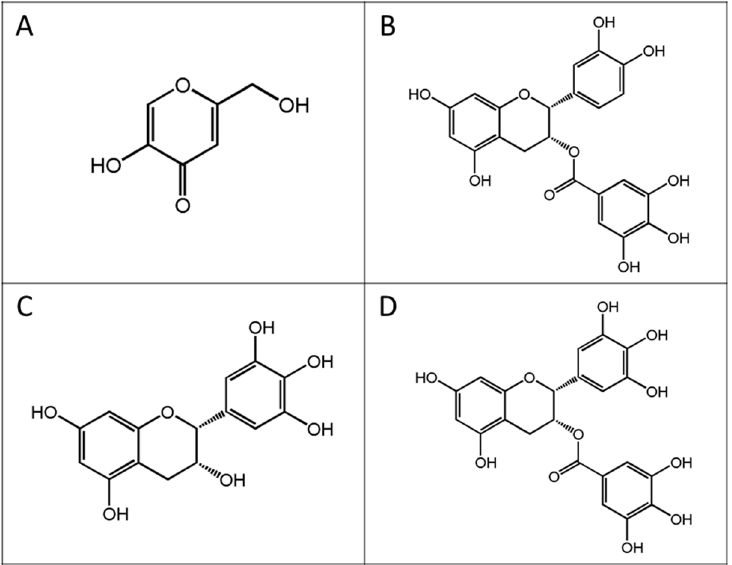
Figure 6. The structures of the compounds used in this study. ( A ) Kojic acid (KA); ( B ) Epicatechin-3-gallate (ECG); ( C ) Epigallocatechin (EGC); ( D ) Epigallocatechin-3-gallate (EGCG).